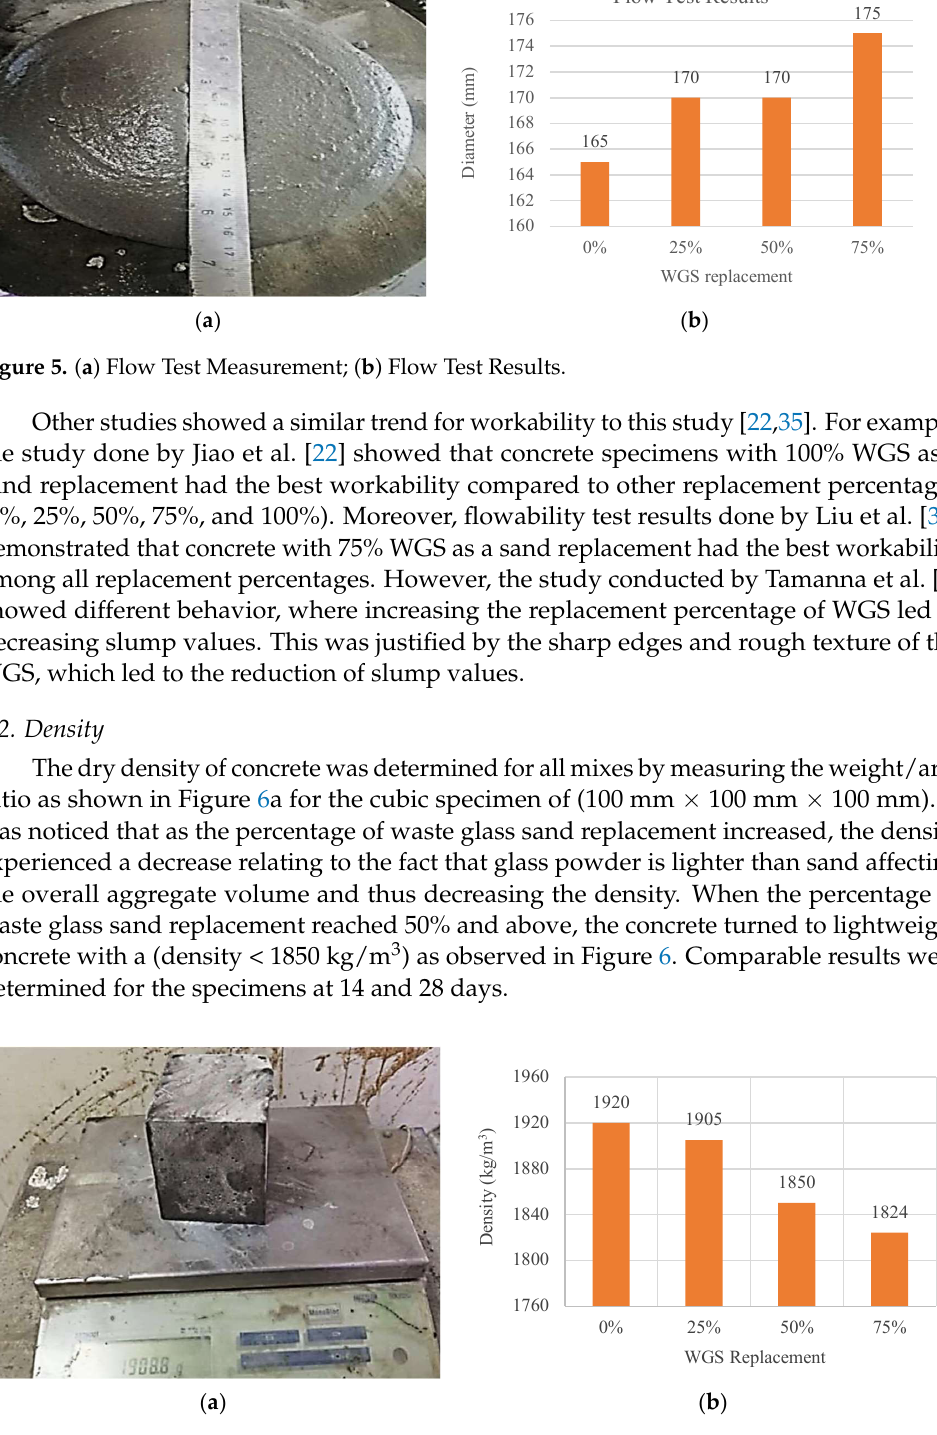
Figure 6. ( a ) Weight Measurement; ( b ) Density of Cubic Specimens at 7 days.